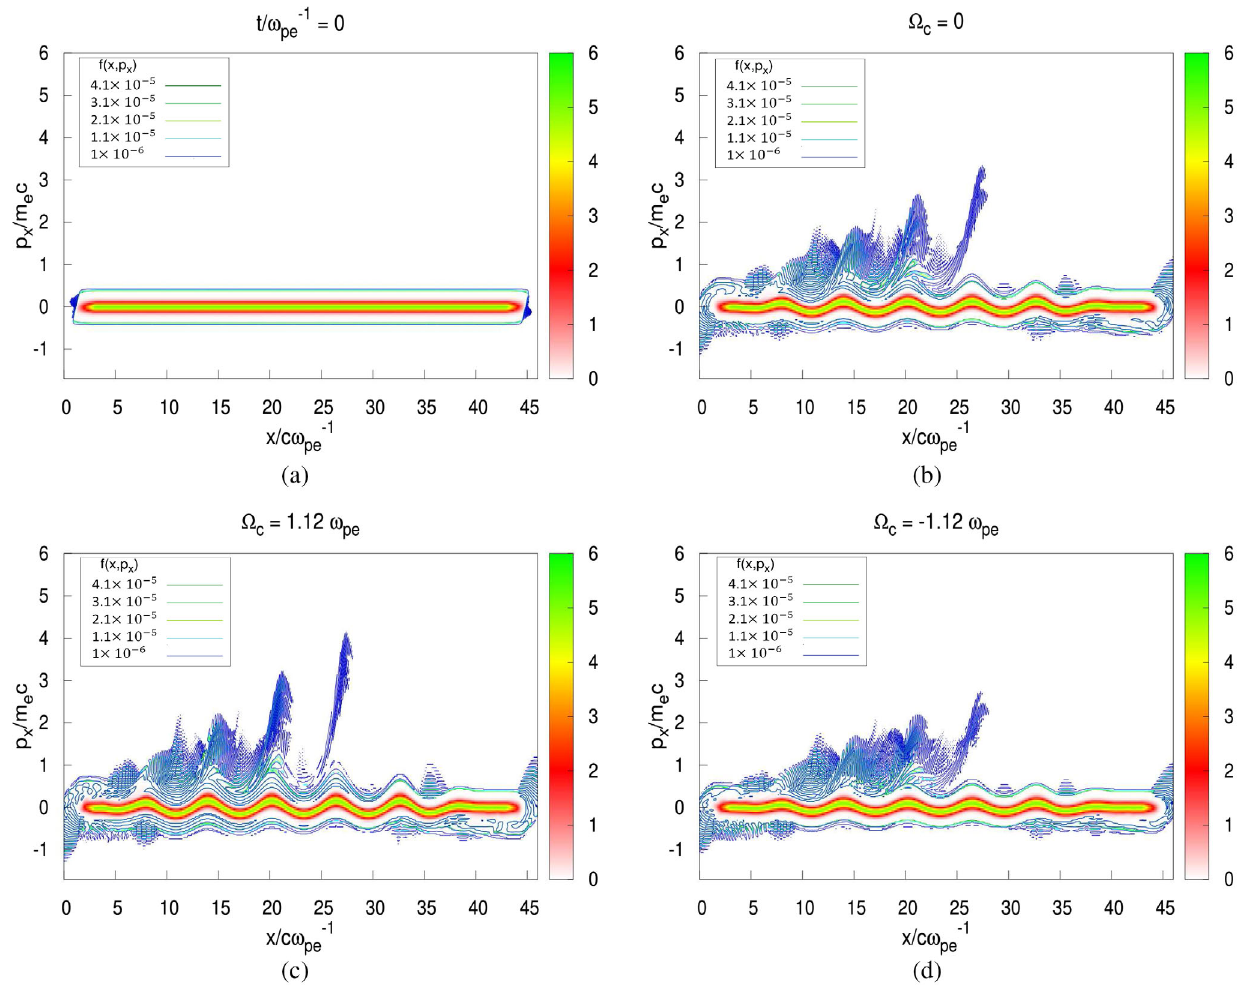
FIG. 5. Contour plots of electron distribution function f ð x; p x Þ in phase space ð x; p x Þ : (a) before the entrance of RCP laser pulse 0 ) and at the time t= ω − 1 ≃ 40 for (b) nonmagnetized plasma slab Ω 0 , (c) plasma slab which are through plasma slab ( t= ω − 1 c ¼ pe ¼ pe embedded in an external magnetic field in positive x direction Ω c ¼ 1 . 12 ω and (d) plasma slab which are embedded in an external pe magnetic field in negative x direction Ω c ¼ − 1 . 12 ω pe